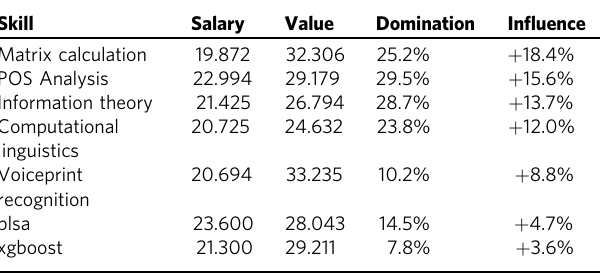
Table 3 Skill ’ s average in fl uence on